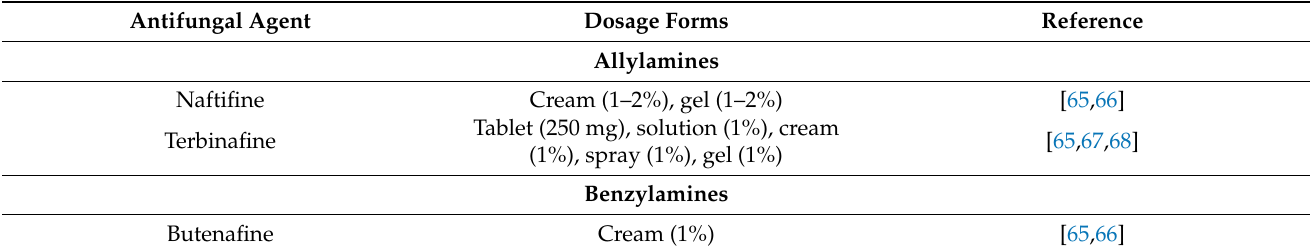
Table 1. Conventional dosage forms of allylamines and